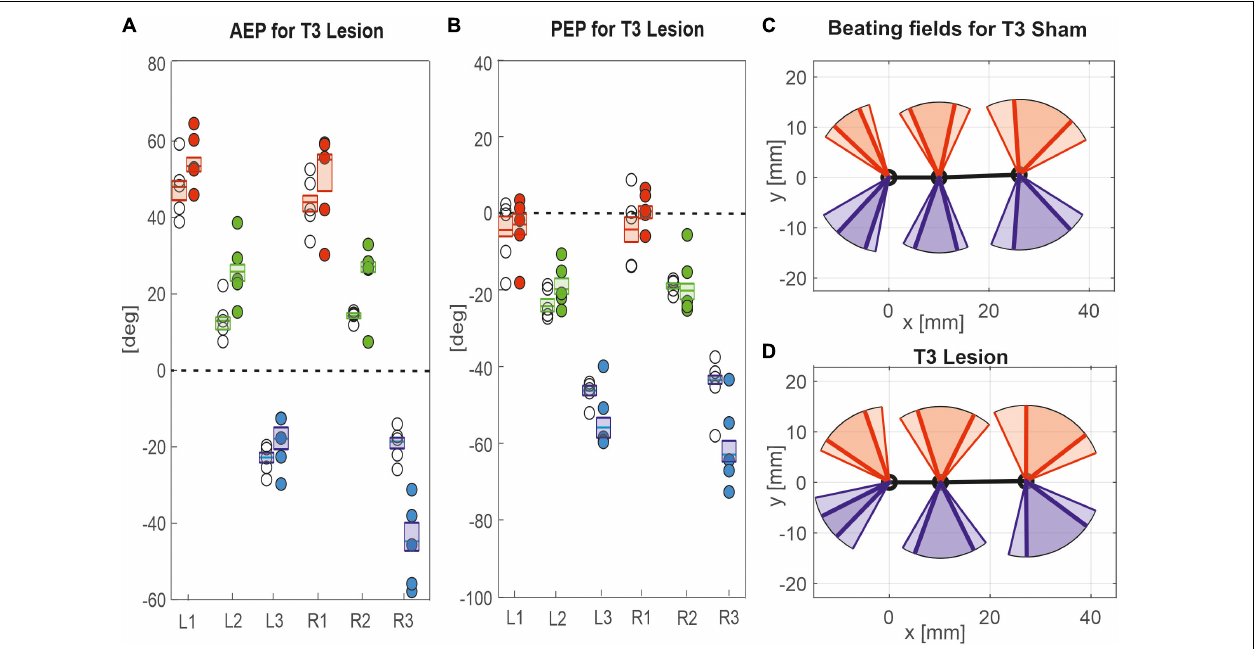
FIGURE 8 | Effects of the T3 lesion on anterior and posterior extreme positions. AEPs (A) and PEPS (B) of all legs following an operation at the meso-to-metathorax connective. Symbols show median extreme positions per animal with a cut connective (filled circles) or with a sham operation (open circles). Boxes show the distributions of all trials per cohort with the median extreme positions and 95% CI. (C,D) Beating fields show both the size and boundaries of the working range of each leg with a sham operation in the metathorax ( C , top) or with a cut meso-to-metathorax connective ( D , bottom). Same graph details as in Figure 7